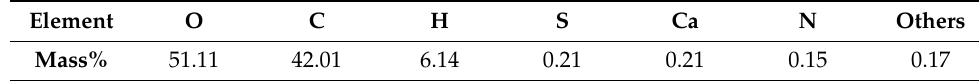
Table 1. Composition (% by mass) of cotton